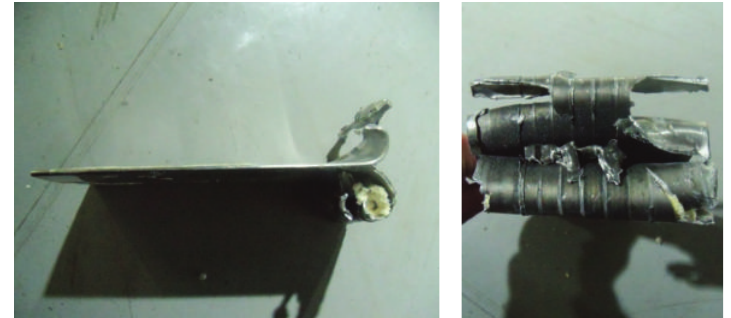
Figure 4: Deformed hollow panel after impact.